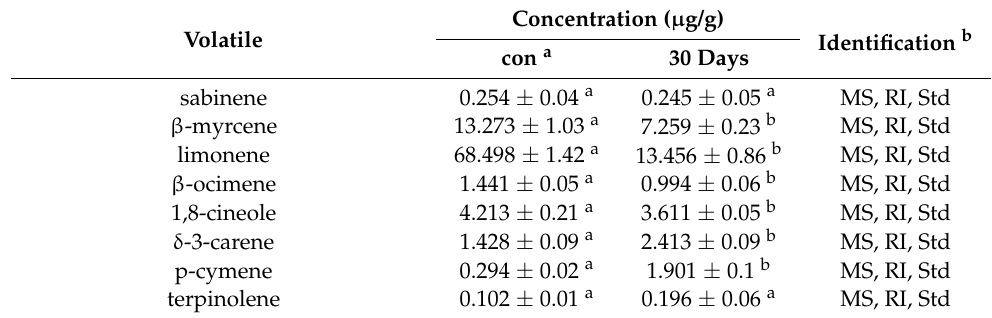
Table 3. Content of volatile compounds of newly prepared fried pepper oil (con) and fried pepper oil stored under UV–O 2 conditions for 30